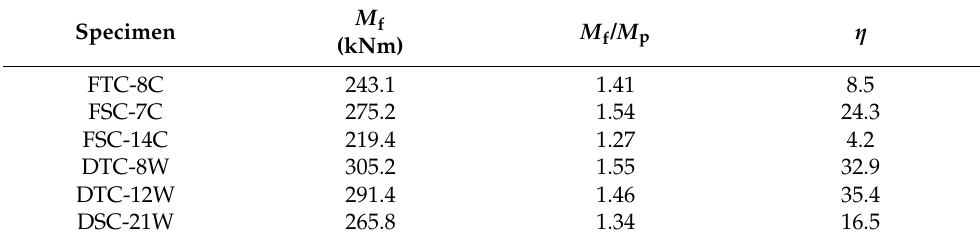
Table 4. Strength magnification and deformation capacity of the specimens.